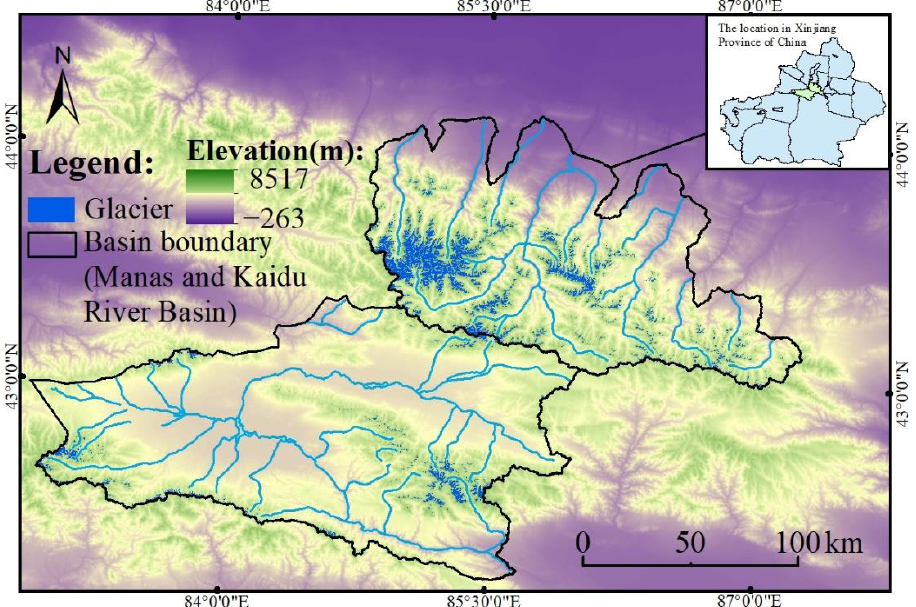
Figure 1. Location of the study area.